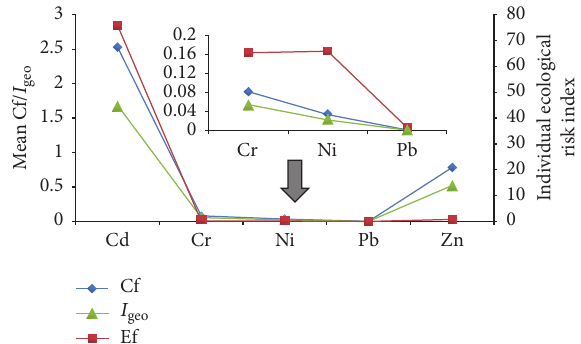
Figure 2: Individual ecological risk index and mean Cf /𝐼 of trace metals for sandflats soil samples of Douglas Creek.